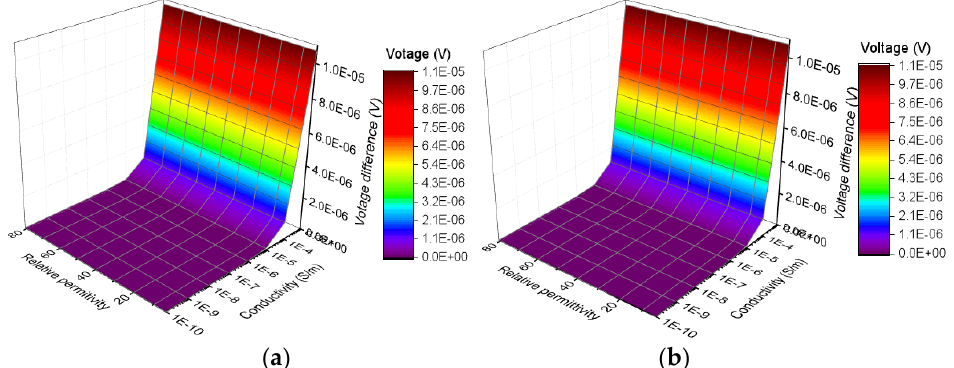
Figure 10. Change of voltage difference between adjacent electrodes with electrical parameters of interface: ( a ) Voltage difference between outer ring electrode and middle ring electrode; ( b ) Voltage difference between inner ring electrode and middle ring electrode.